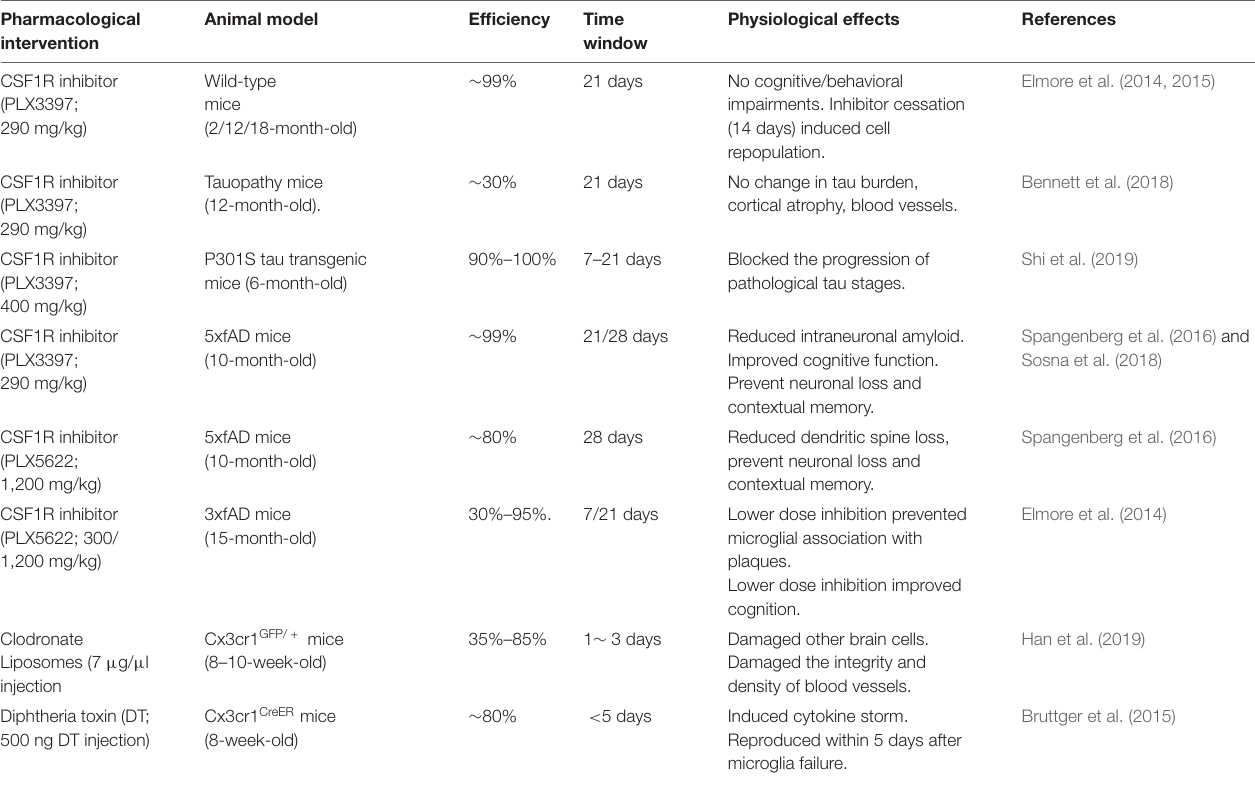
TABLE 1 | Summary of pharmacological microglia depletion approaches. Pharmacological